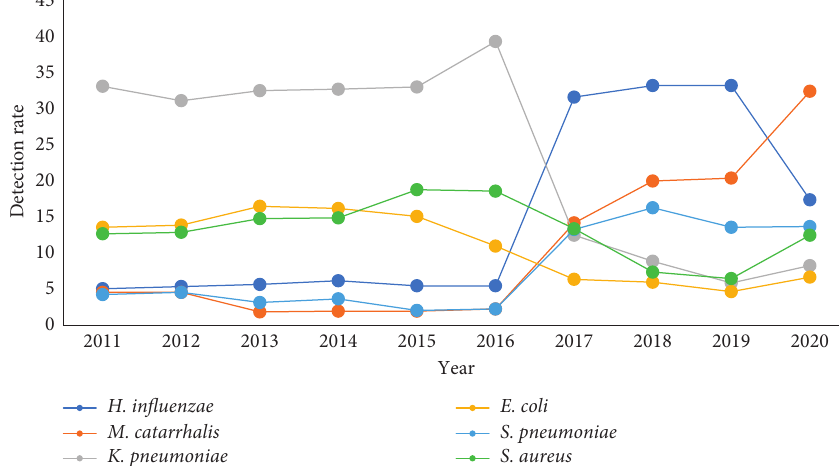
Figure 3: Changes in the detection rate of pathogens in lower respiratory tract from 2011 to 2020